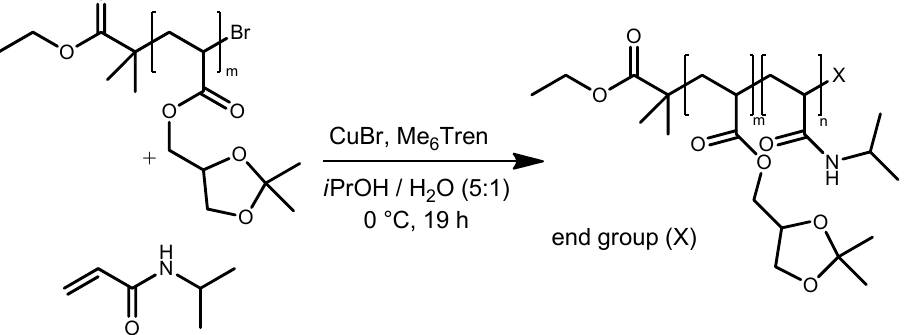
Figure 10. Synthesis of PSKA- b -PNIPAAm block copolymers via ATRP with PSKA macroinitiators.